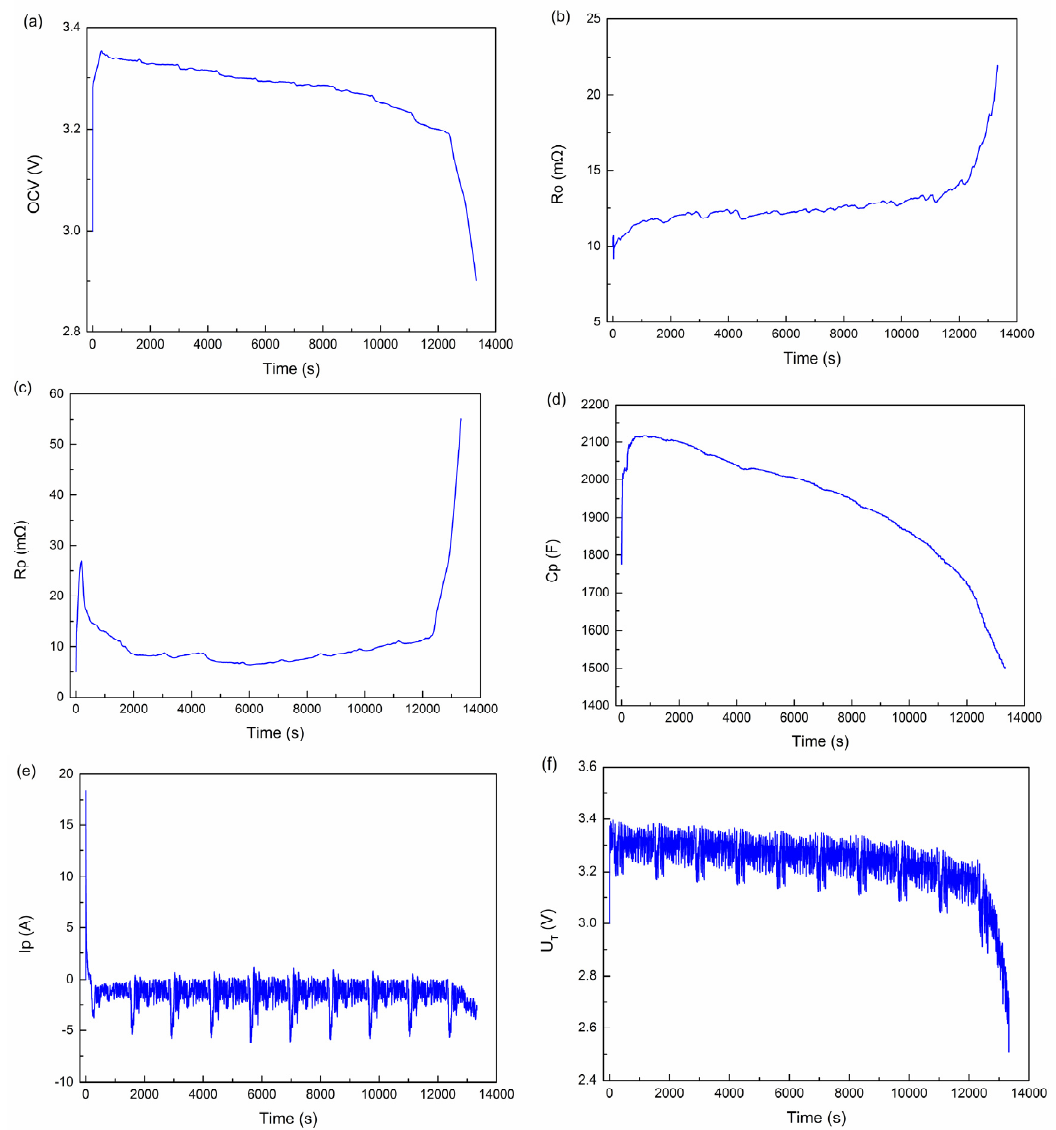
Figure 15. Online parameter and state estimation results in the FUDS test at 40